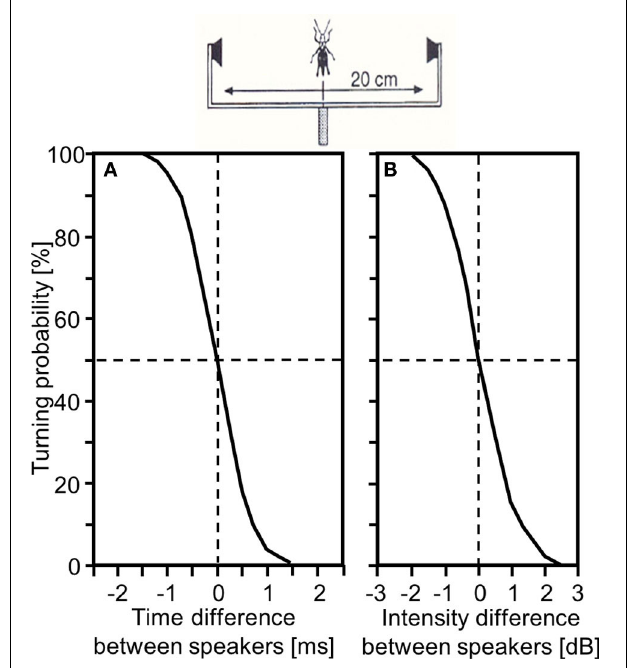
FIGURE 4 | Behavioral demonstration that small interaural time differences (A) or interaural intensity differences (B) in the order of only 1ms and 1dB influence the turning tendency of male Chorthippus biguttulus in a quasi-dichotic ear stimulation experiment (modified from von Helversen and Rheinlaender,